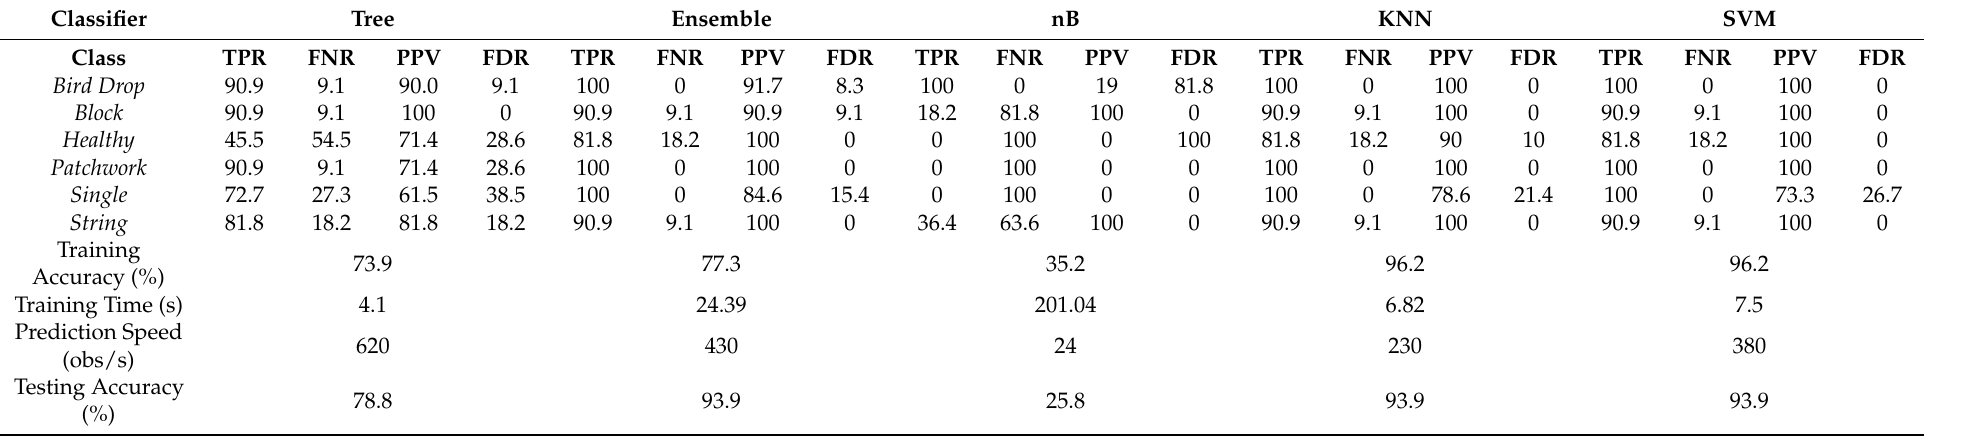
Table 6. GoogleNet-based features calculation and shallow classification.